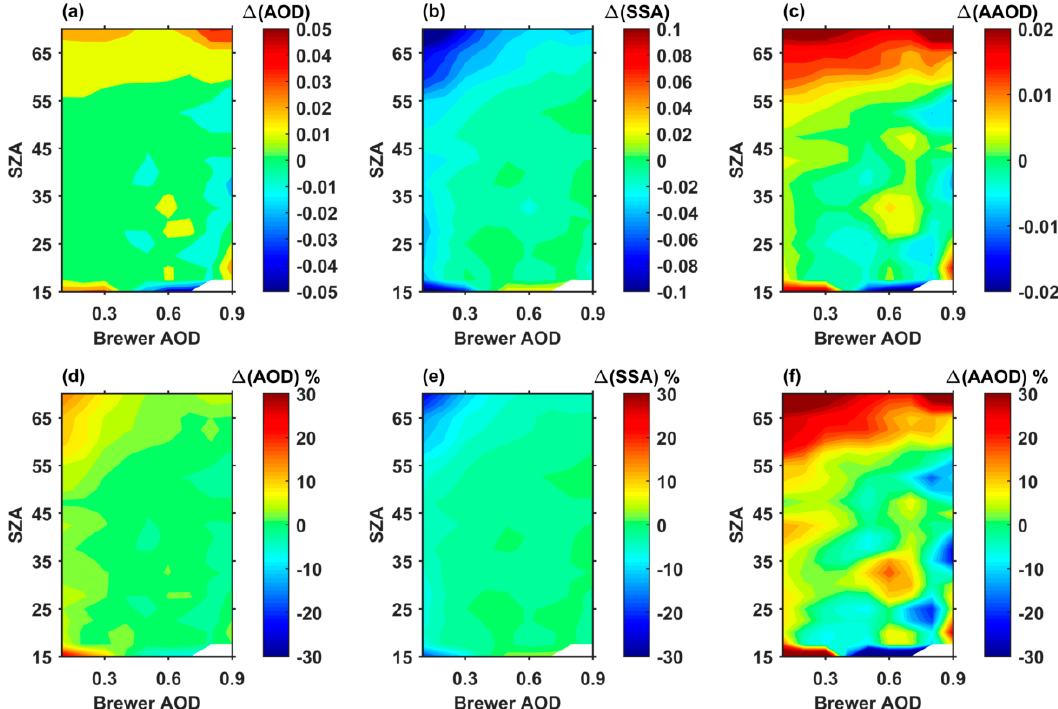
Figure 1. ( a ) absolute differences in aerosol optical depth (AOD) at 340 nm between Brewer#086 and CIMEL, ( b ) the corresponding differences in the calculated SSA and ( c ) the corresponding differences in the calculated aerosol absorption optical depth (AAOD). The same differences in % are presented in panels ( d ), ( e ), and ( f ) respectively.